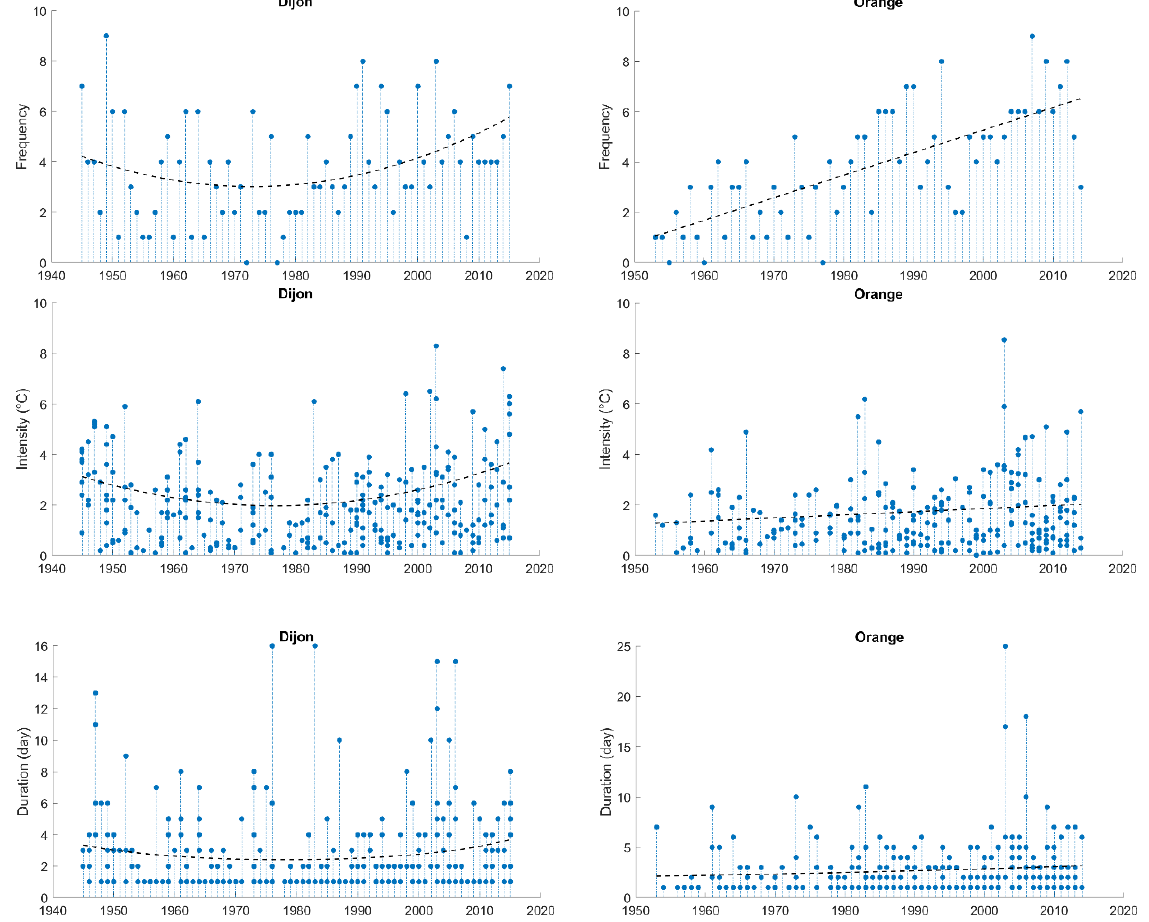
Figure 4. Time series for the heat spell frequency, intensity, and duration for both stations. The dashed line denotes the trend in the time-dependent distribution scale parameters ( 𝜆 𝑡 for the frequency, 𝜎 𝑡 for the intensity, and 𝑝 𝑡 for the duration).